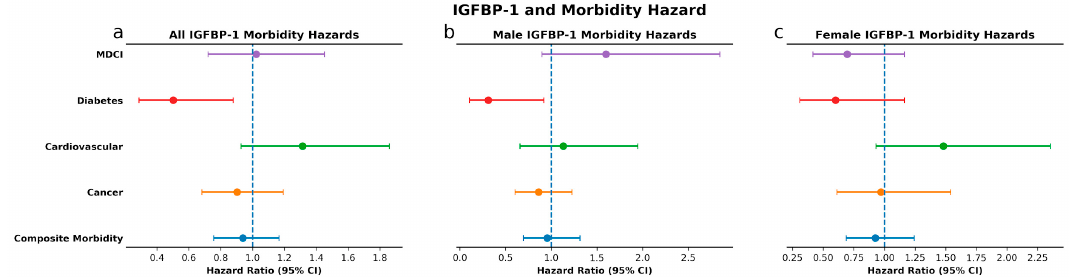
Figure 6. IGFBP-1 and morbidity hazard. Sex and age-adjusted morbidity hazards for all individuals ( a ), and age-adjusted morbidity hazard for males ( b ) and females ( c ) with high levels of IGFBP-1 as compared to individuals with low levels.